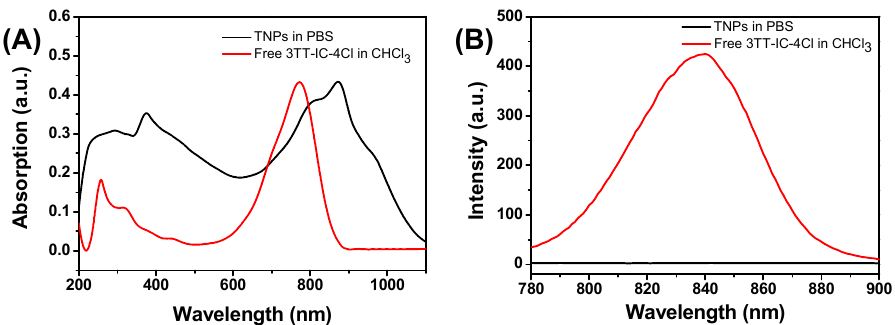
Figure 4. ( A ) UV–Vis absorption spectra of free 3TT-IC-4Cl (red) and TNPs (black), and ( B ) Fluorescence spectra of free 3TT-IC-4Cl (red) and TNPs (black).